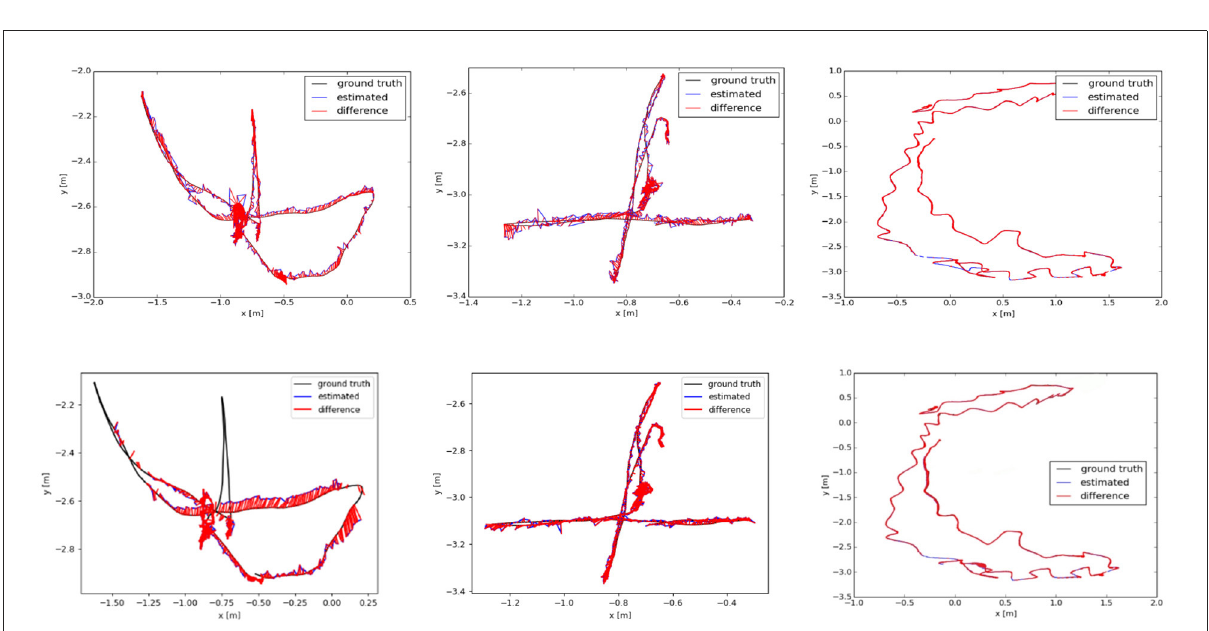
FIGURE14 The (top) row is the trajectory error graph of SMR, and the (bottom) row is the trajectory error graph of ours. The ground truth, the estimated camera motion, and the localization error for each camera pose are represented as the black, blue, and red segments, respectively.